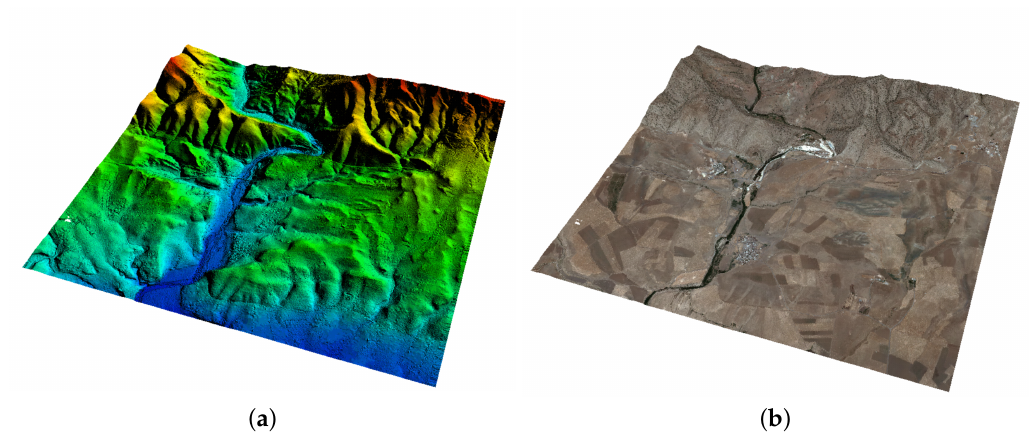
Figure 10. ( a ) 3D visualization of the DEM with color intensity visualization scaled according to the elevation; ( b ) the pansharpened image projected on the DEM.